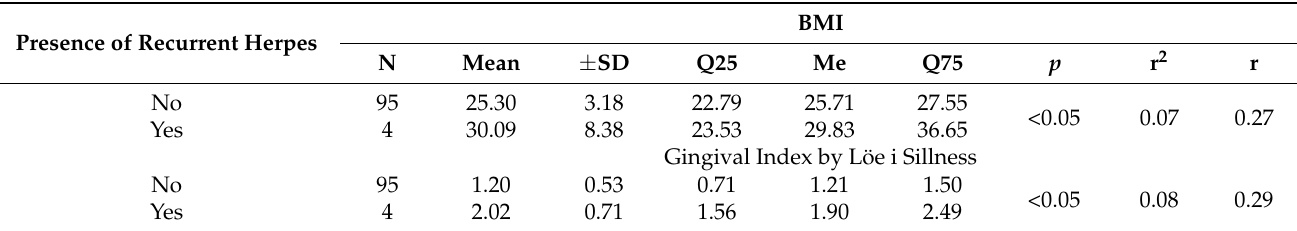
Table 7. Incidence of recurrent herpes and BMI and GI in the study group